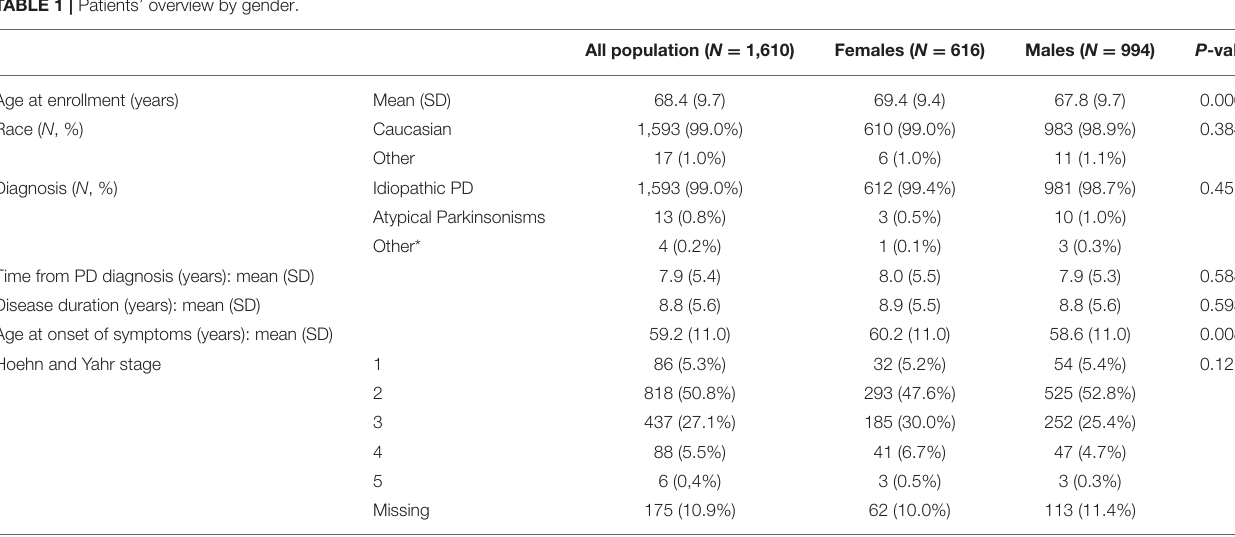
TABLE 1 | Patients’ overview by